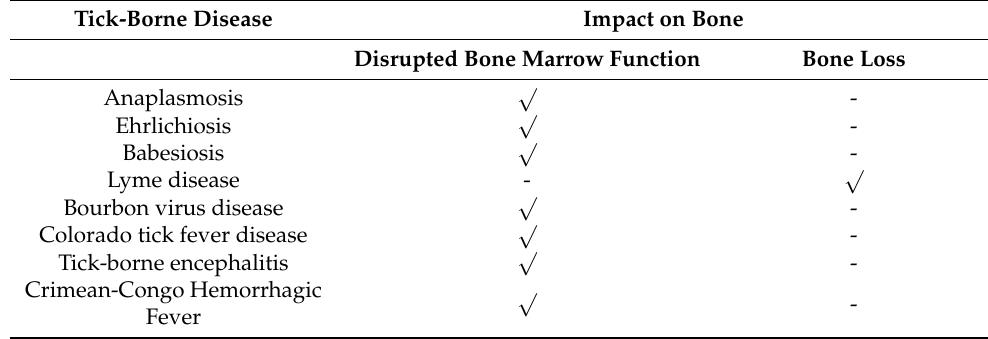
Table 2. Tick-borne diseases with reported human bone phenotypes. Tick-Borne Disease Impact on Bone Disrupted Bone Marrow Function Bone Loss Anaplasmosis